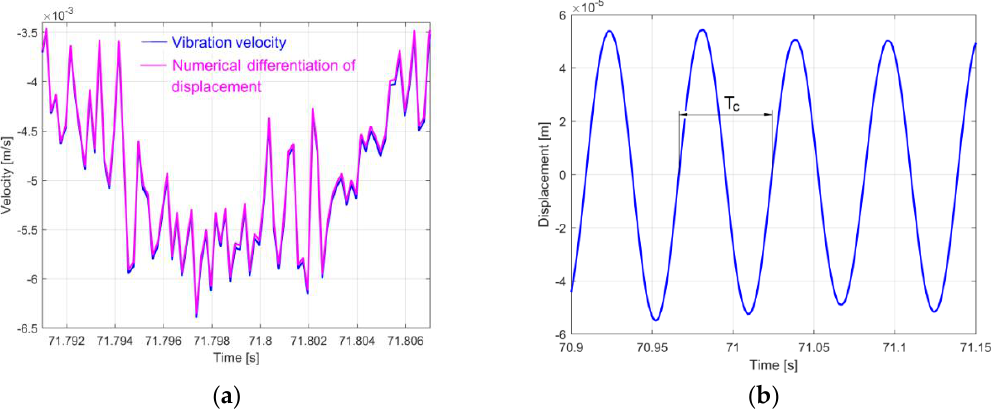
Figure 8. ( a ) A detail concerning the evolution of velocity (Figure 3) overlaid on the numerical differentiation of the displacement depicted in Figure 7; and ( b ) a detail of area A of Figure 7 with T c , the period of the resultant vibration.